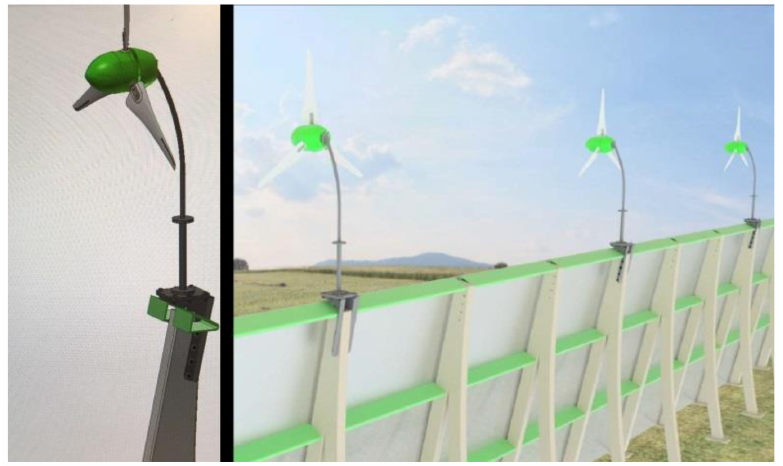
Figure 6. Visualization of the micro wind turbine structural integration with the noise barrier. The observed directional data were then compared to the wind direction measured from the sonic anemometers next to the wind turbine as can be seen in Figure 7. The rotational speed of the micro wind turbine (RPM) was measured via a magnetic pulse counter installed on the hub’s shaft. The RPM measured in combination with the local wind speed was used to define the tip speed ratio (TSR) of the micro wind turbine. The yaw orientation was also measured with the digital compass installed on the hub of the